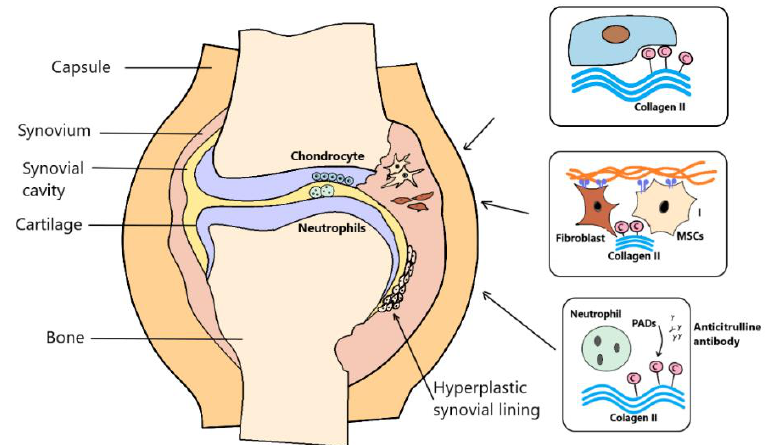
Figure 1. Antibodies to citrullinated proteins are specific serological markers of rheumatoid arthritis (RA). Anti-citrulline protein antibodies (ACPA) specifically bind to citrullination after translational modification. ACPAs are synthesized by immune cells in the panus, such that the trigger for ACPA production is the autoantigen present in the affected joint. Peptidyl arginine deiminase (PAD) are characteristic of synovial fluid. In inflamed tissues, PAD could act on the citrullination of extracellular matrix (ECM) proteins such as fibrinogen and collagen. Citrulline collagen II, fibrinogen and vimentin were found in the joints of RA patients.